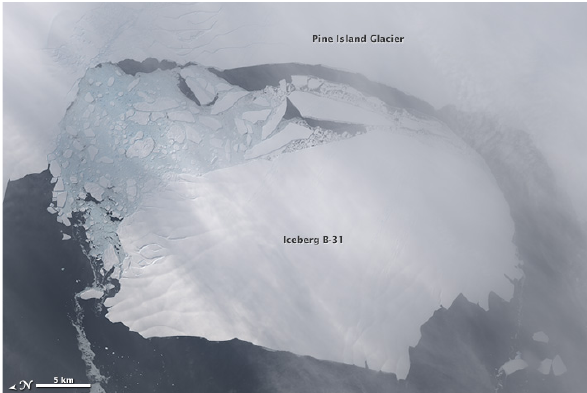
Figure 7. Separation of B31 iceberg from Pine Island Glacier, USGS/NASA. LANDSAT image, 13 November 2013.